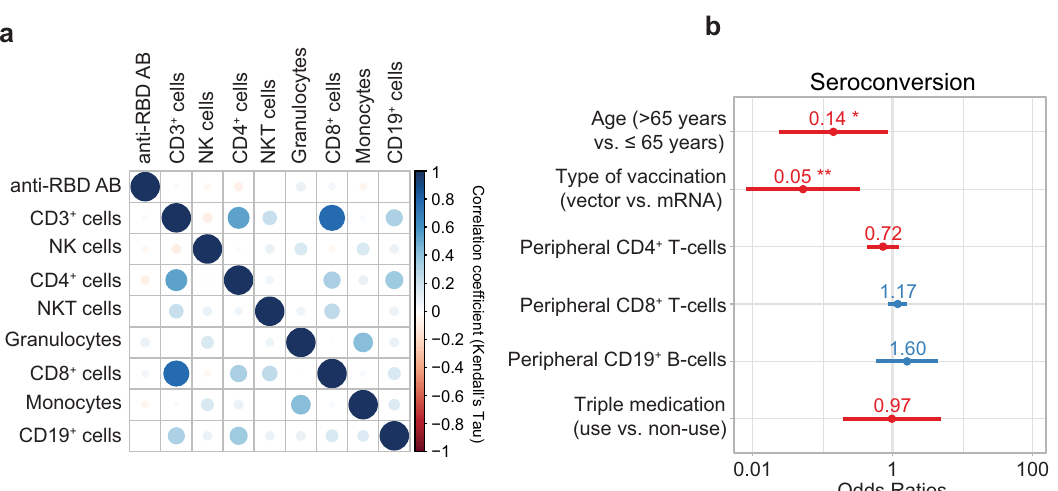
Fig. 4 | Predictors of vaccination response. a Pairwise correlation plot of anti- bodies to the receptor-binding domain (RBD) of the viral spike (S) protein after third vaccination and leukocyte subsets in patients. Correlation coef fi cients are displayed as Kendall ’ s τ . Source data are provided as a Source Data fi le. b Odds